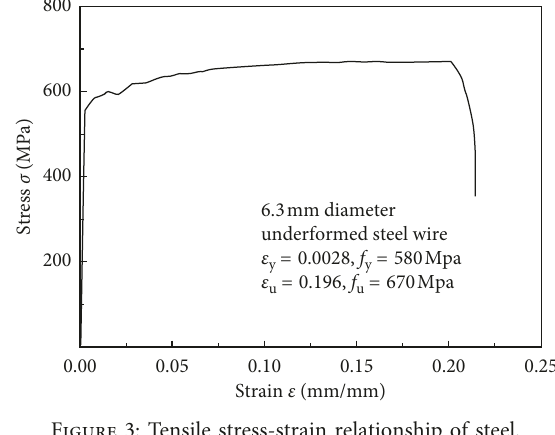
Figure 3: Tensile stress-strain relationship of